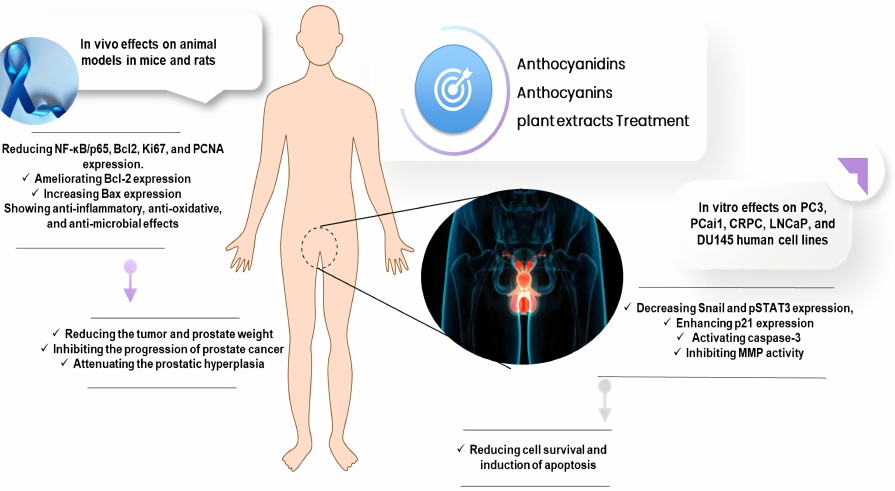
Figure 3. The mechanism of actions of anthocyanidins/anthocyanins on the treatment of prostate